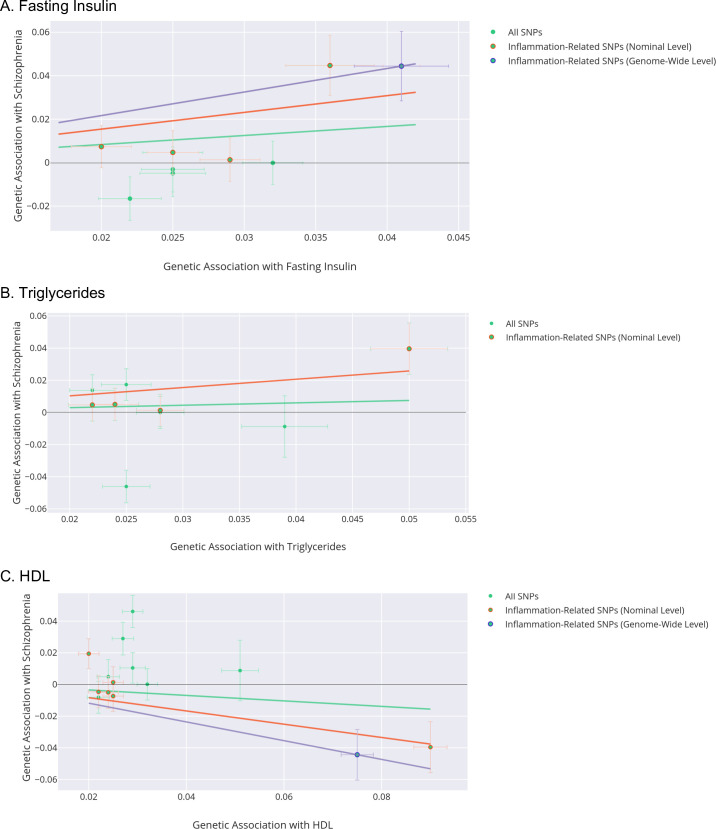
MR Analyses Testing Associations between Insulin Resistance Phenotypes (Fasting Insulin (A), Triglycerides (B) and HDL (C)) and Schizophrenia, Highlighting Inflammation-Related SNPs. Points in plots represent the association of the genome-wide significant insulin-resistance single nucleotide polymorphisms (SNPs) and their association with schizophrenia (Y axis) and the exposure (X axis). SNPs are denoted by green points in the plot. Inflammation-related SNPs at genome-wide significance are denoted by a purple border. Inflammation-related SNPs at nominal significance are denoted by a red border. Whiskers represent standard errors. Lines on the plot represent inverse-variance weighted (>1 SNP) or linear regression (1 SNP) of all-SNPs (green line), inflammation-related SNPs at genome-wide significance (purple line) and inflammation-related SNPs at nominal significance (red line).